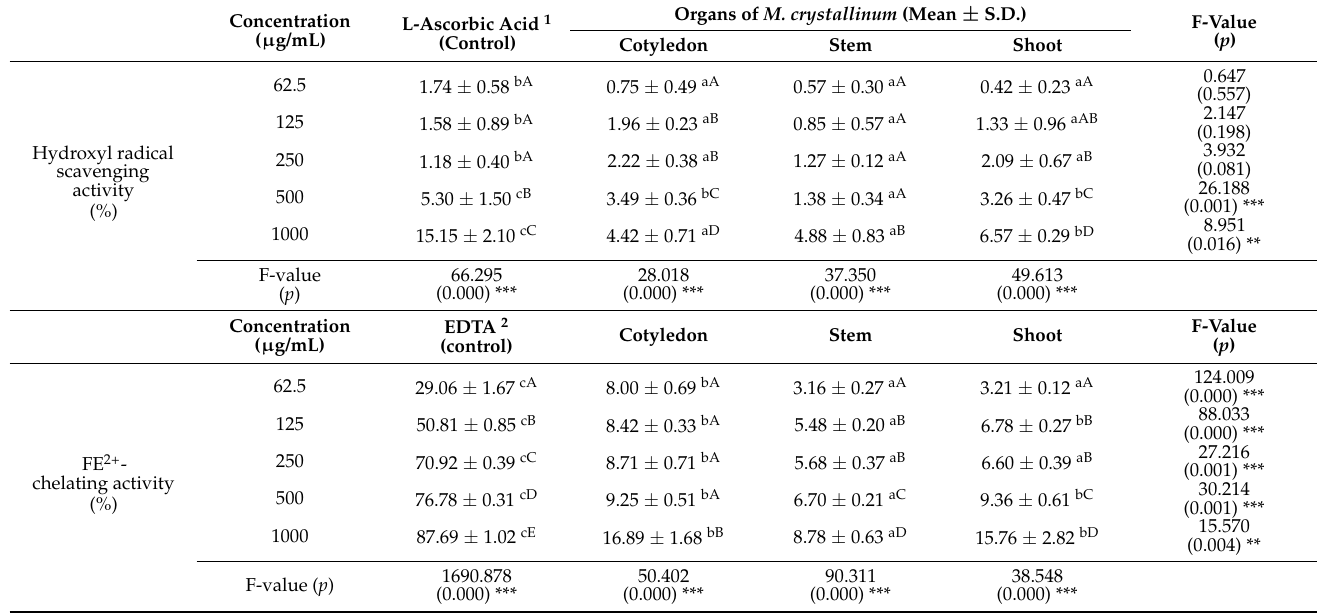
Table 3. Hydroxyl radical scavenging activity and FE 2+ chelating activity with mean ± S.D. (%) ranging from 62.5 µ g/mL to 1000 µ g/mL of ethanol extract from the cotyledon, stem, and leaf of M. crystallinum